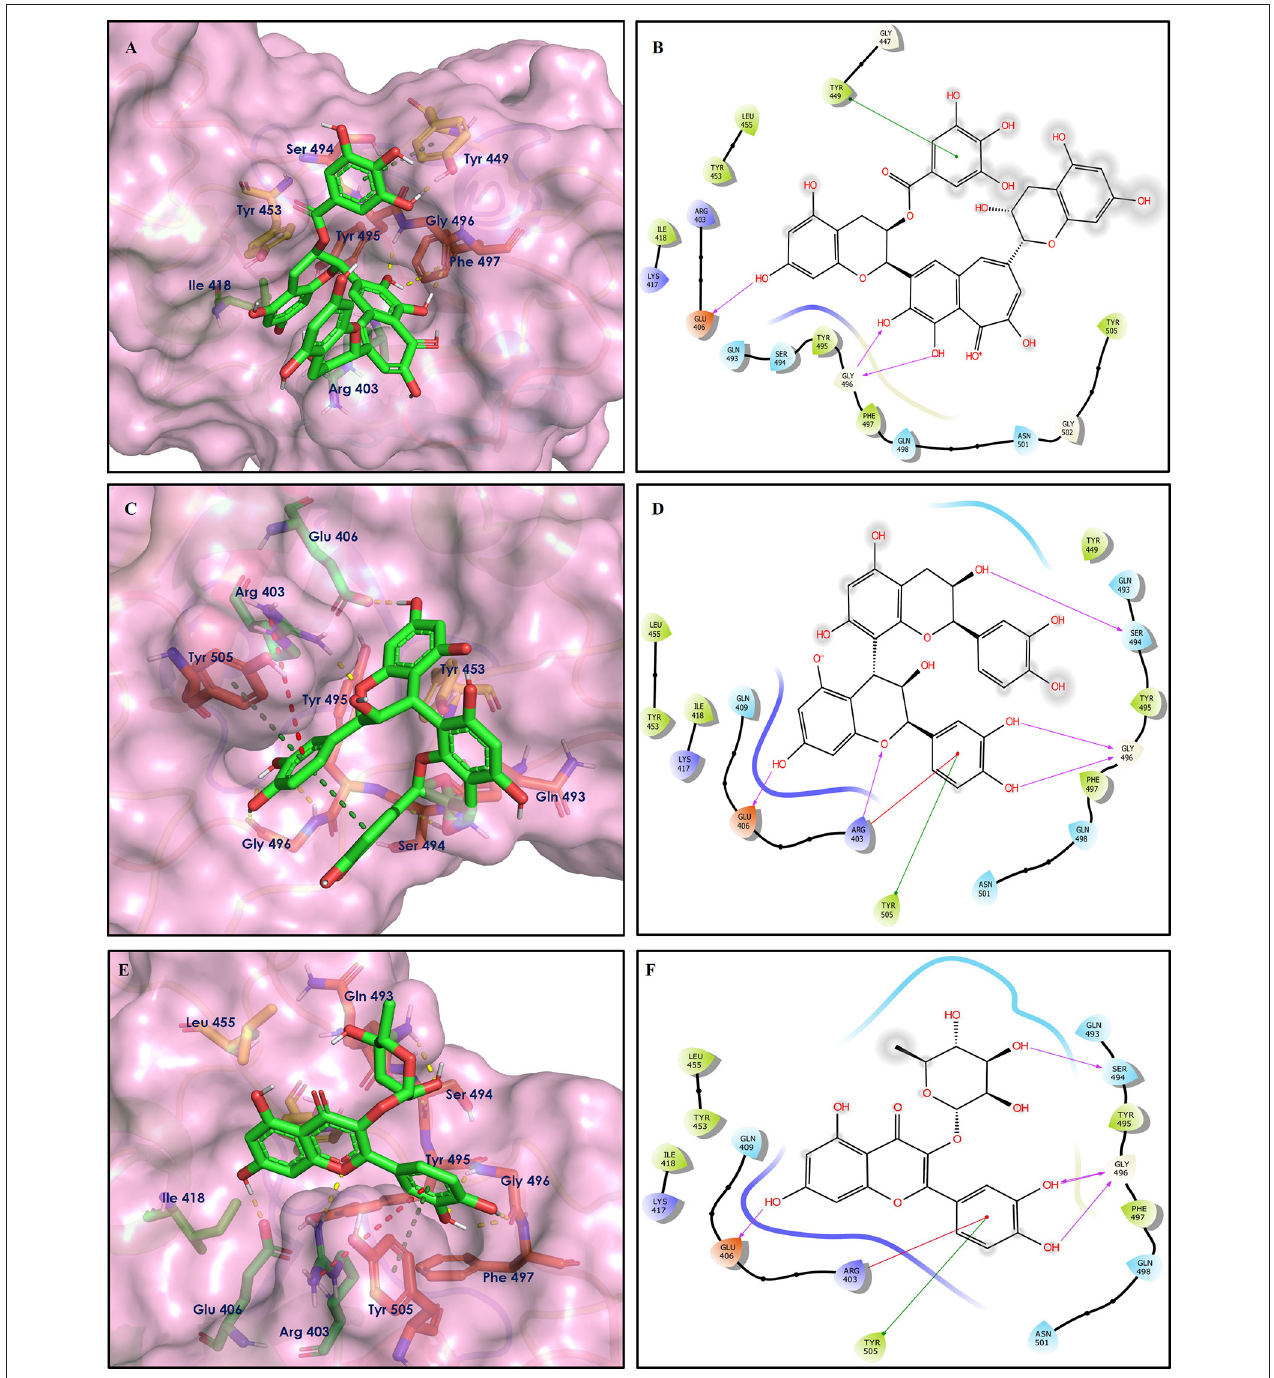
FIGURE 8 | Docking interactions of compounds (52, 14, 19 : A–F) in the active sites of Spike RBD. (A,C,E) 3D-binding mode of compounds 52 , 14 , and 19 with Spike RBD active site, respectively. Ligands are shown as green sticks, Spike RBD residues are shown as atom type color sticks, hydrogen bonds formed between ligands and receptor are depicted as yellow dotted lines, π - π stacking interaction as green dotted lines and π -cation interaction as red dotted lines. (B,D,F) 2D-ligand interaction diagram of compounds 52 , 14 , and 19 with Spike RBD active site, respectively.